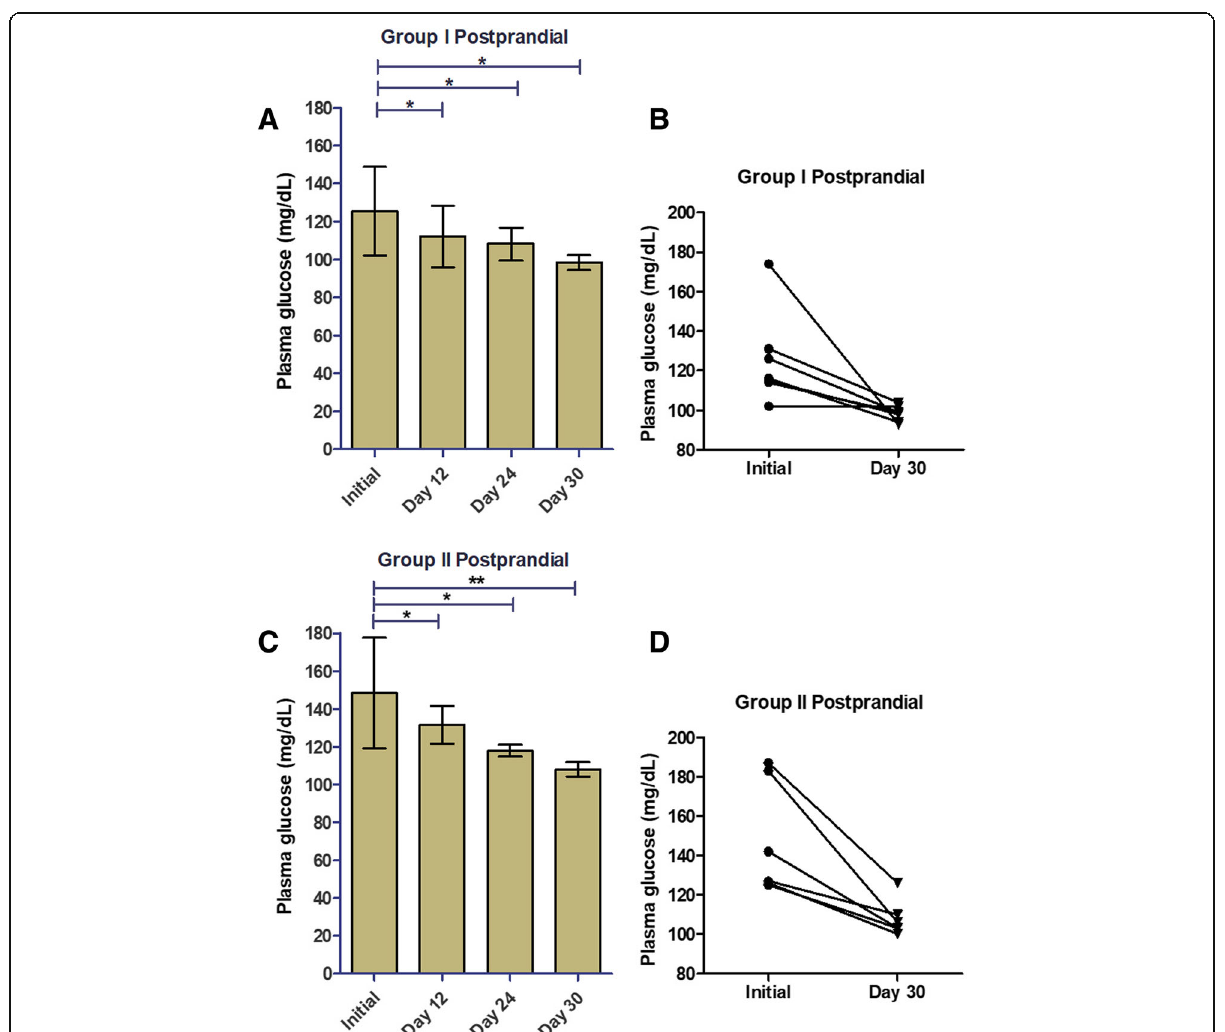
Fig. 3 In both normal and prediabetic individuals, PCE supplementation decreased postprandial blood glucose. After the initial day of the study, subjects consumed one PCE capsule immediately after finishing lunch each day for the duration of the study and postprandial glucose was measured 2 h after the start of lunch. Postprandial plasma glucose levels were measured and recorded on days 1 (initial), 12, 24, and 30 ( a , c ). We plotted individual study subject plasma glucose levels for the initial day and day 30 of the study ( b , d ). Data shown are mean ± SD for a and c . We calculated statistical significance (*, p ≤ 0.05; **, p ≤ 0.01) by comparing glucose levels measured at each time point to the initial value using a two-tailed t-test in GraphPad Prism 5.0